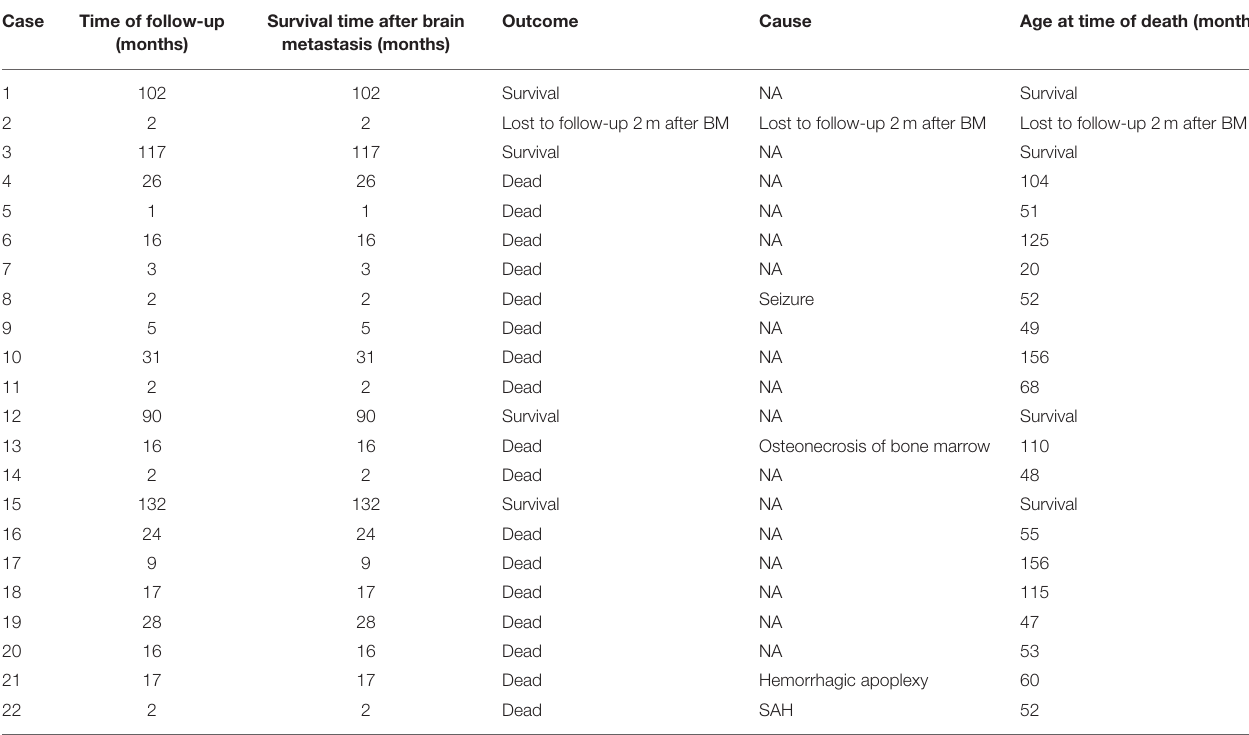
TABLE 4 | Summary of prognosis of NB patients with IM.